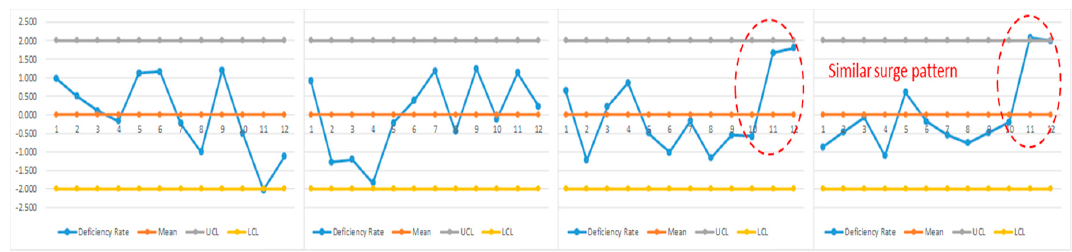
Figure 9. The control chart for deficiency 02 (2015–2018).